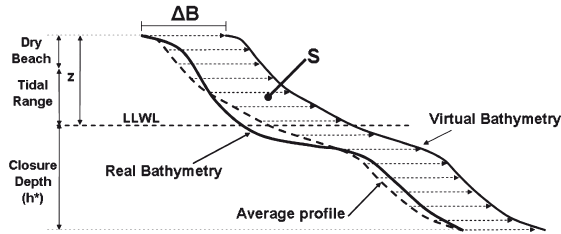
Fig . 4. – Virtual bathymetric survey obtained by displacing the av- erage profile from the initial bathymetry by a constant width ∆ B calculated as D/(z+h*), where D is the volume density (nourishment project) or the erosion/accretion rate (if a previous monitoring is available).